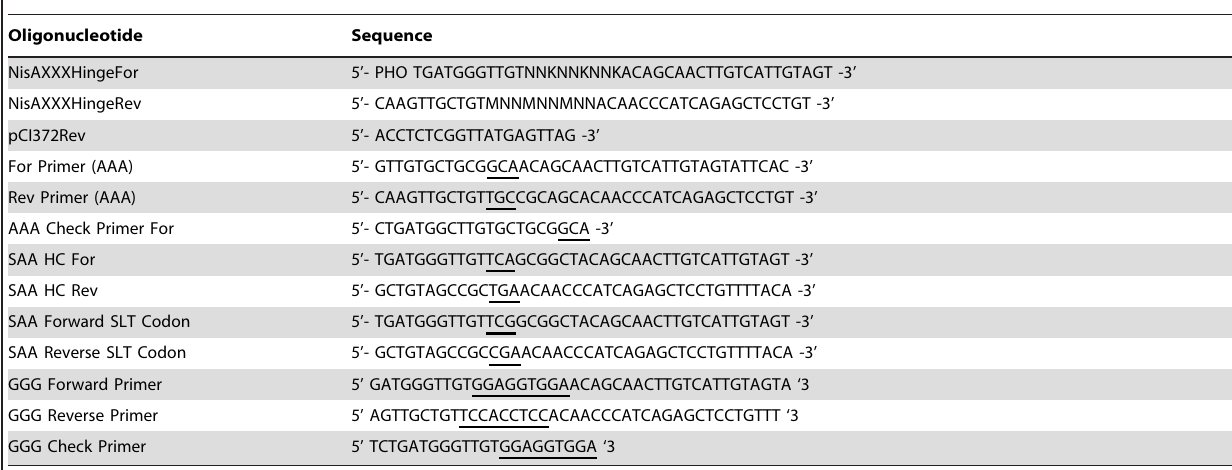
Table 2. Oligonucleotides used in this